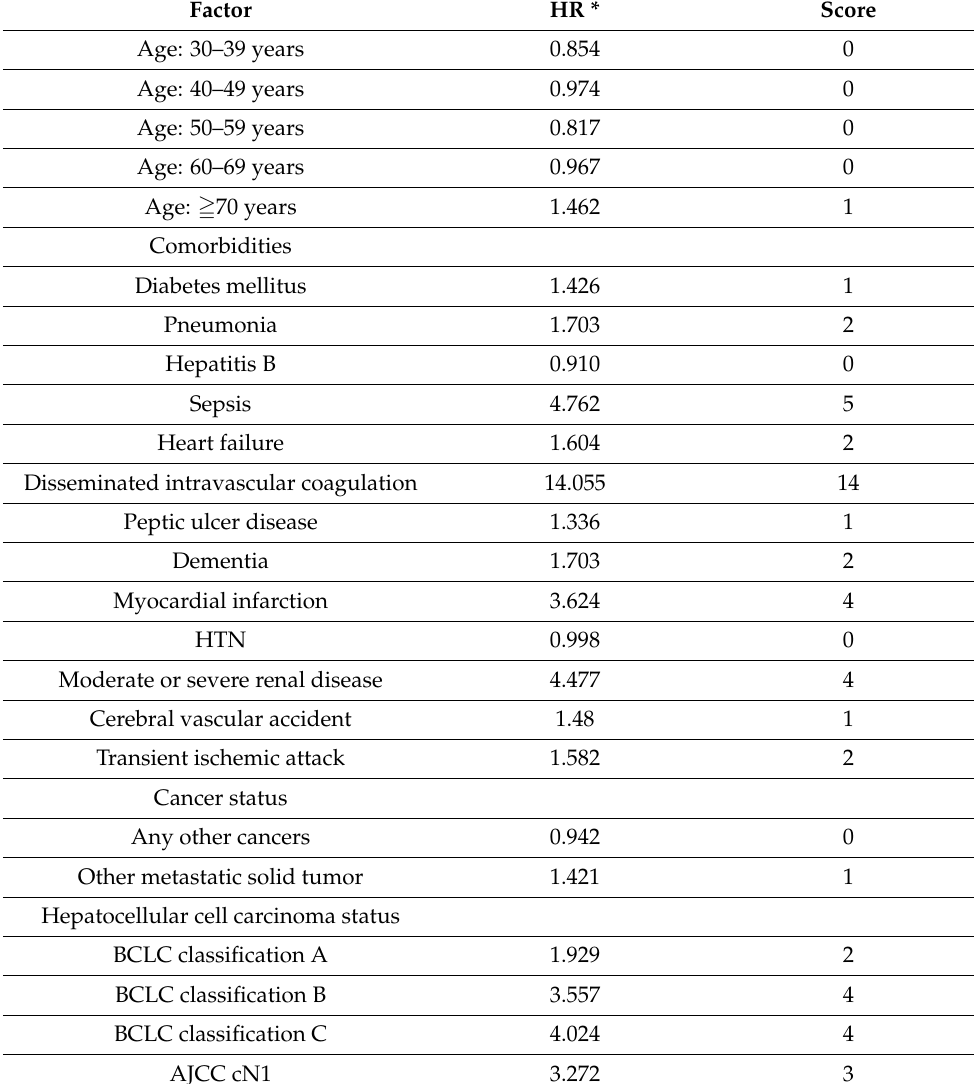
Table 3. Stepwise Selection of the Multivariate Cox Proportional Hazards Model for All-Cause 90-Day Mortality in Patients with Hepatocellular Carcinoma Undergoing Major Hepatectomy.